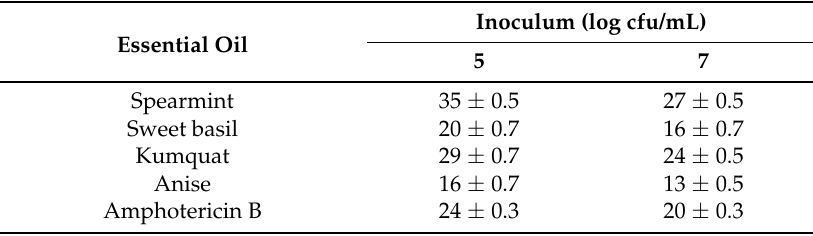
Table 3. Antimicrobial activity of the essential oils against Saccharomyces cerevisiae monitored by the disk diffusion assay. Amphotericin B was used as positive control.